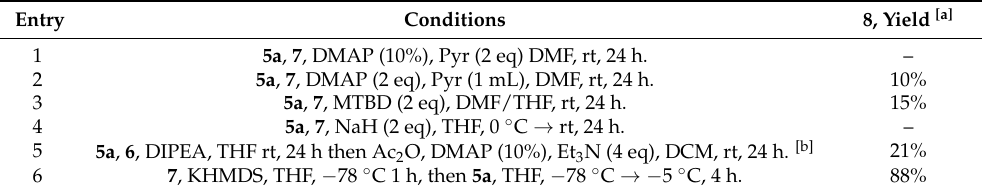
Table 1. Synthetic approaches to N-acyl carbamates and optimisation.